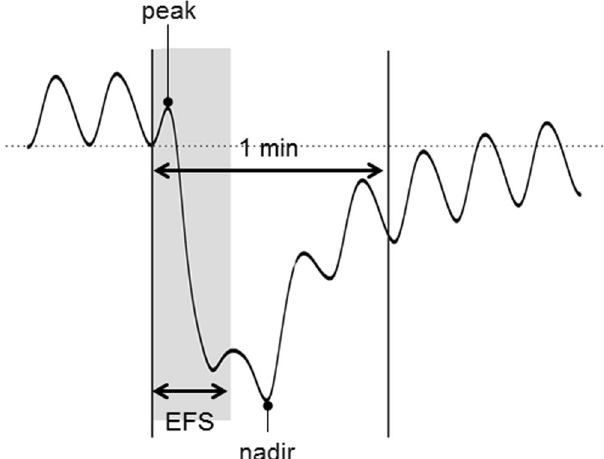
Figure 7. Peak and nadir of the response induced by electrical field stimulation (EFS) of human gastric muscle. Peak is the highest value, while nadir stands for the lowest value during the first 1 minute after the initiation of EFS.